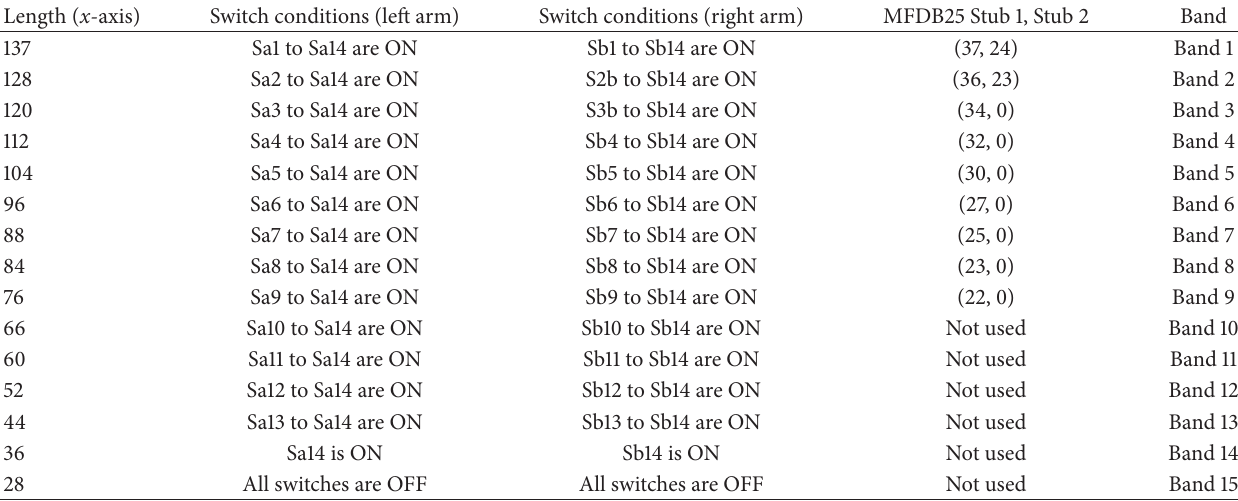
Table 3: Switch configuration states for different length of radiating element. Units are in mm.